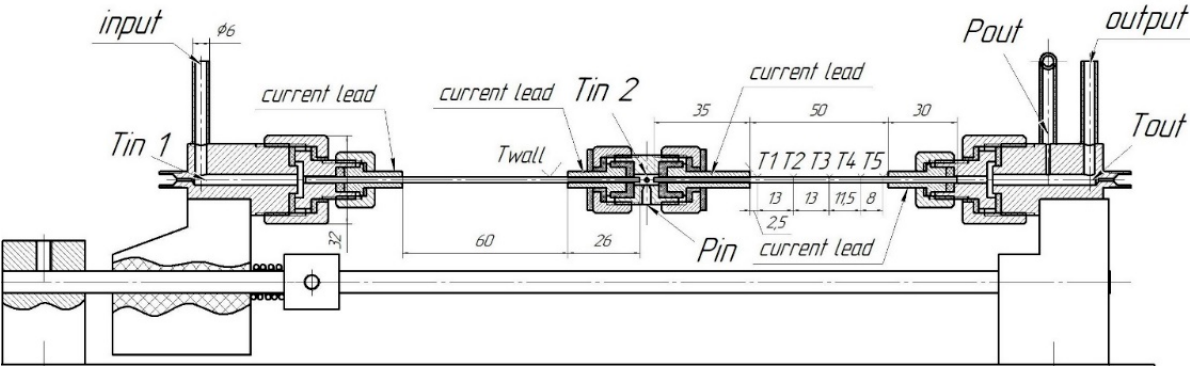
Figure 1. Experimental setup: (1) thermocompressor, (2) tank, (3) and (5) filters, (4) balloon with refrigerant, (6) multistage centrifugal pump, (7) с oriolis flowmeter, (8) pre-heater, (9) roughing- down pump, (10) test section, (11) current transducer, (12) recuperative heat exchanger, (13) bypass line.